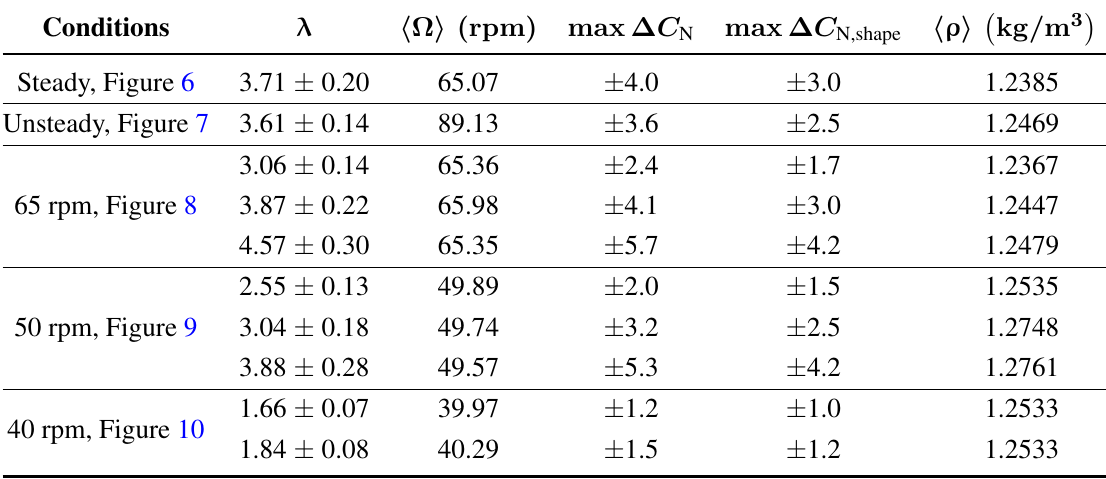
Table 1. Summary of the results and maximum measurement errors. Note that λ at the unsteady conditions is estimated with Ω and V variations for the steady conditions; Section 3.1.